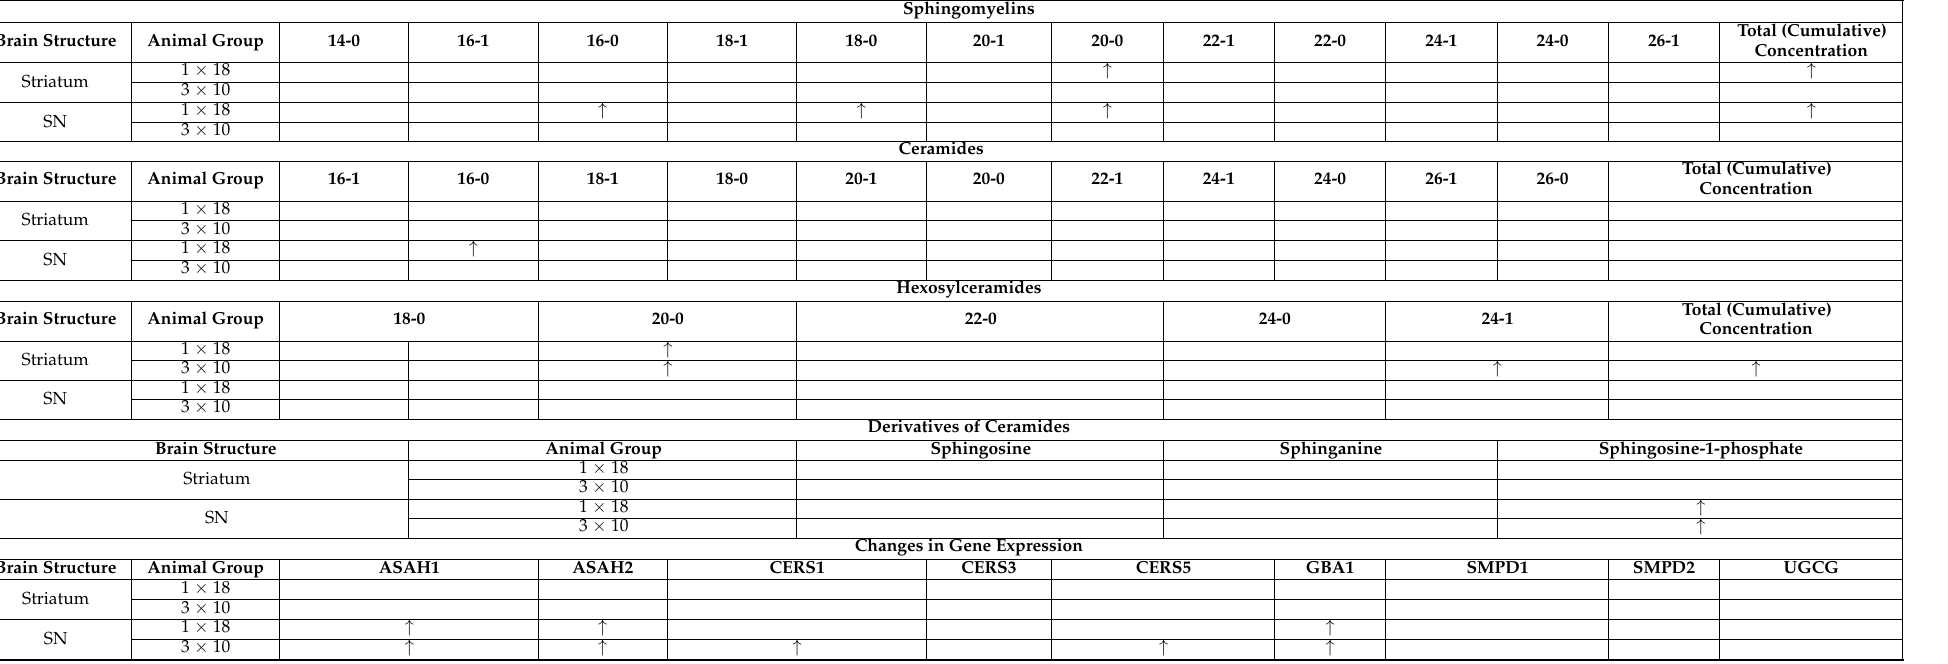
Table 2. Summary table of changes in sphingolipid content and changes in the gene expression of sphingolipid metabolism enzymes in mice in the striatum and in the substantia nigra 2 weeks after subcutaneous administration of MPTP: once at a single dose of 18 mg/kg and three times at a single dose of 10 mg/kg with a 2-h interval between injections compared to the controls